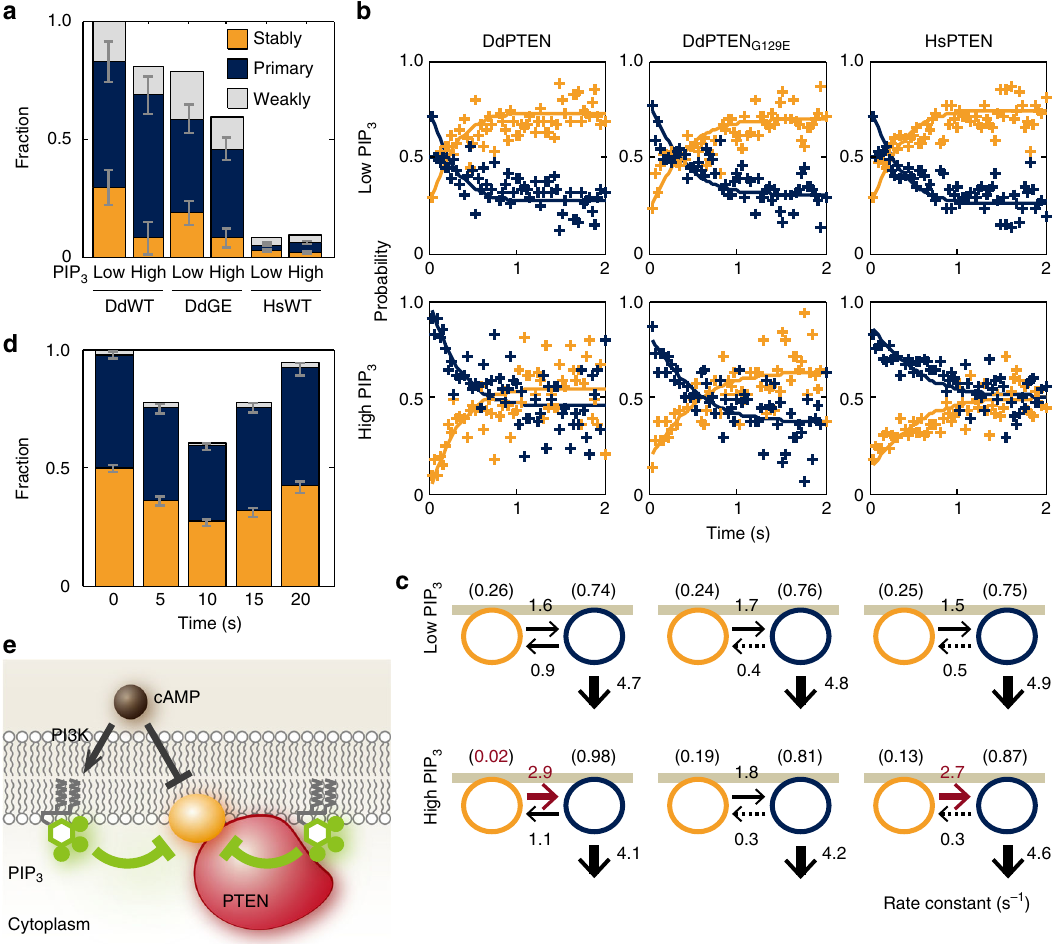
Fig. 5 Negative regulation of PTEN membrane localization through binding sites sensitive to PIP3. a Three diffusion states of DdPTEN, DdPTEN G129E and HsPTEN molecules were detected on the low and high PIP3 membranes. The values were normalized to the total number of DdPTEN molecules on the low PIP3 membranes. Error bars: 95% con fi dence intervals. P = 0.000, 0.002, and 0.000 (low PIP3 vs. high PIP3 for DdPTEN, DdPTEN G129E , and HsPTEN) and 0.000 and 0.000 (DdPTEN vs. DdPTEN G129E and DdPTEN vs. HsPTEN under the low PIP3 conditions). b Stably (orange) and transiently (blue) binding states of membrane-bound molecules displayed in a time series after the onset of membrane binding. The lines represent the fi tting to the solutions of the simultaneous differential equations in equation (6). c State transitions and membrane-dissociation kinetics. Numbers without parenthesis represent rate constants (sec − 1 ). Numbers in parenthesis represent probabilities of adopting the respective state at the moment of membrane association. d Three binding states of DdPTEN molecules undergoing a transient response to uniform cAMP stimulation in pi3k1-5 -null cells ( n = 3342 molecules, 16 cells). The values were normalized to the total number of DdPTEN molecules before the stimulation. Error bars: 95% con fi dence intervals. P = 0.004, 0.000, 0.000 and 0.000 (before stimulation vs. 0 – 5 s, 5 – 10 s, 10 – 15 s and 15 – 20 s after stimulation). P values were obtained by likelihood-ratio test. e A model for negative regulation of PTEN membrane localization. It is assumed that a speci fi c binding site (orange circle) acts as the stabilizer that associates with PTEN in the stably bound state and that this binding site is inhibited by PIP3 via PTEN-dependent and – independent mechanisms as well as by cAMP